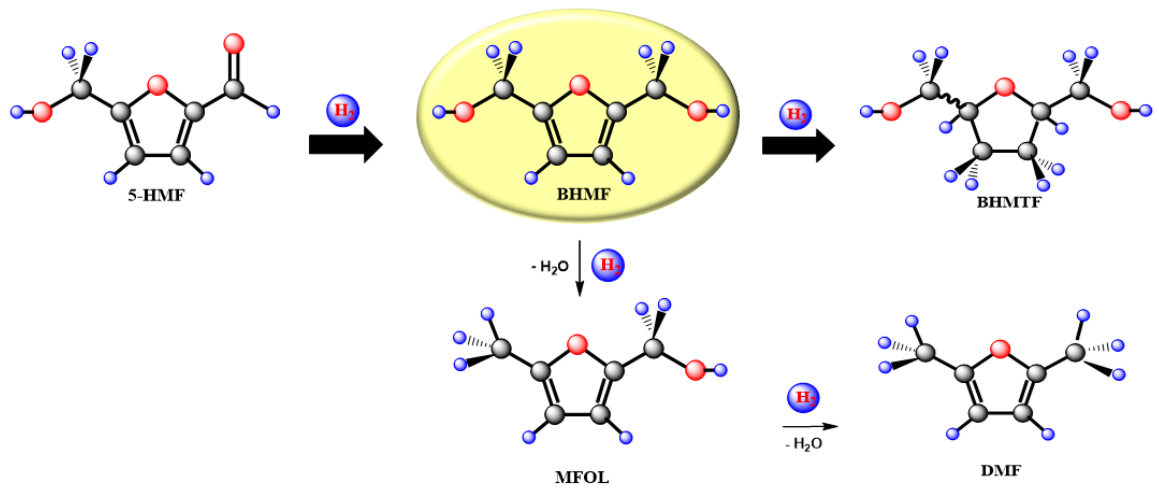
Figure 1. Reaction scheme for the hydrogenation of 5 − hydroxymethylfurfural (HMF). Products: 2,5 − bis(hydroxymethyl)furan (BHMF); 5 − methyl − 2 − furanmethanol (MFOL); 2,5 − dimethylfuran (DMF); 2,5 − bis(hydroxymethyl)tetrahydrofuran (BHMTF).